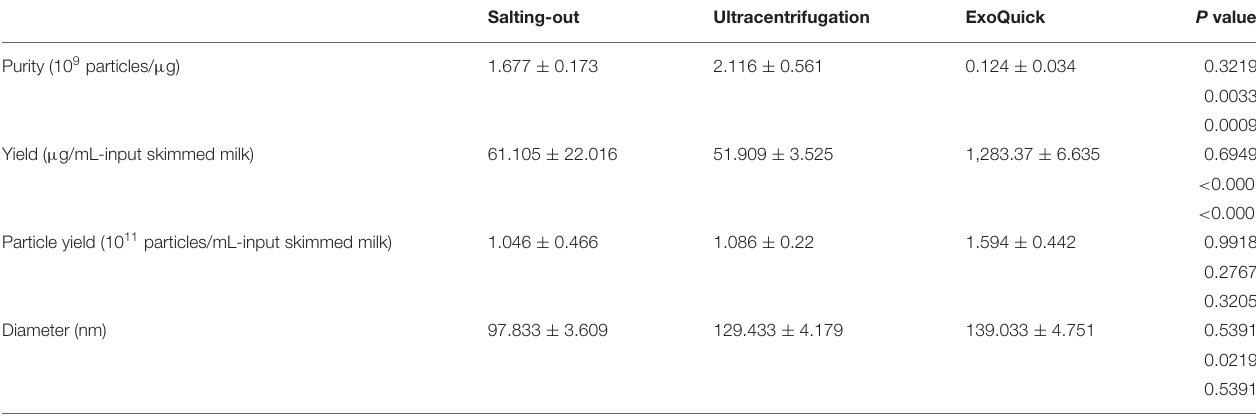
TABLE 1 | Separation of BM-EVs via different isolation